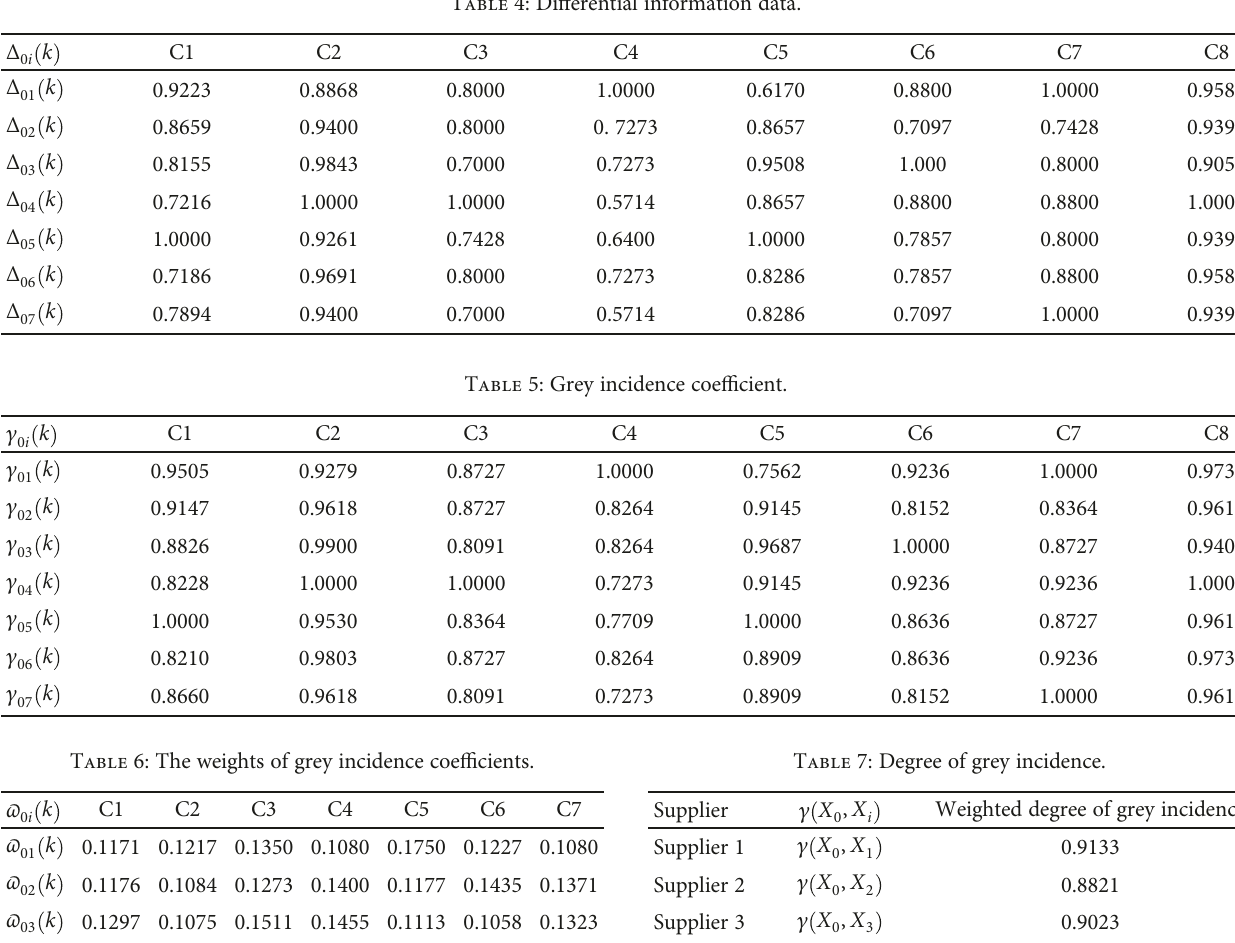
Table 4: Di ff erential information